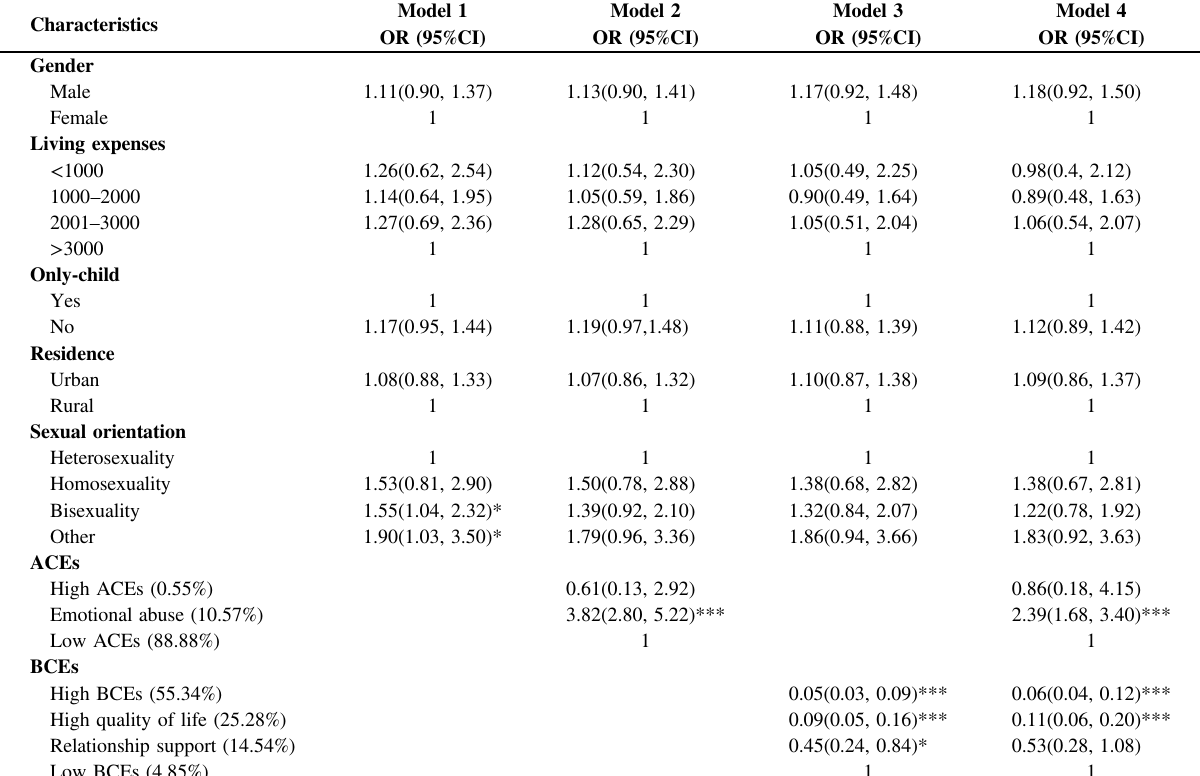
Table 3 Associations between childhood experiences and depression among Chinese undergraduates